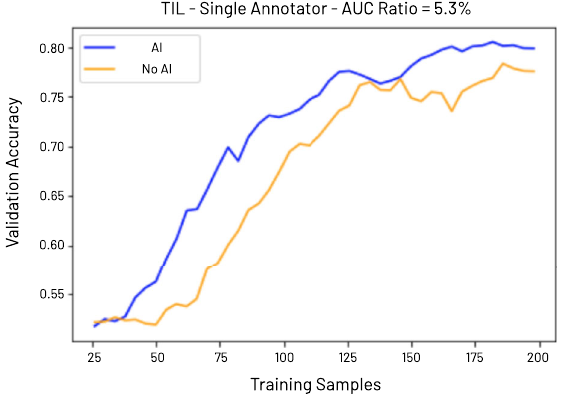
Fig. 5 Effectiveness metric. We consider a data set, D, to be more effective than another, E, if a model trained on D has a higher validation accuracy than a model trained on E, and both D and E cost the same to annotate (i.e., both have the same number of data points and annotations). To this end, we use the AUC of a model ’ s validation accuracy vs number of training samples as a measure of effective- ness, with a higher AUC indicating higher effectiveness and the ratio in AUC between two curves allowing a comparison between two